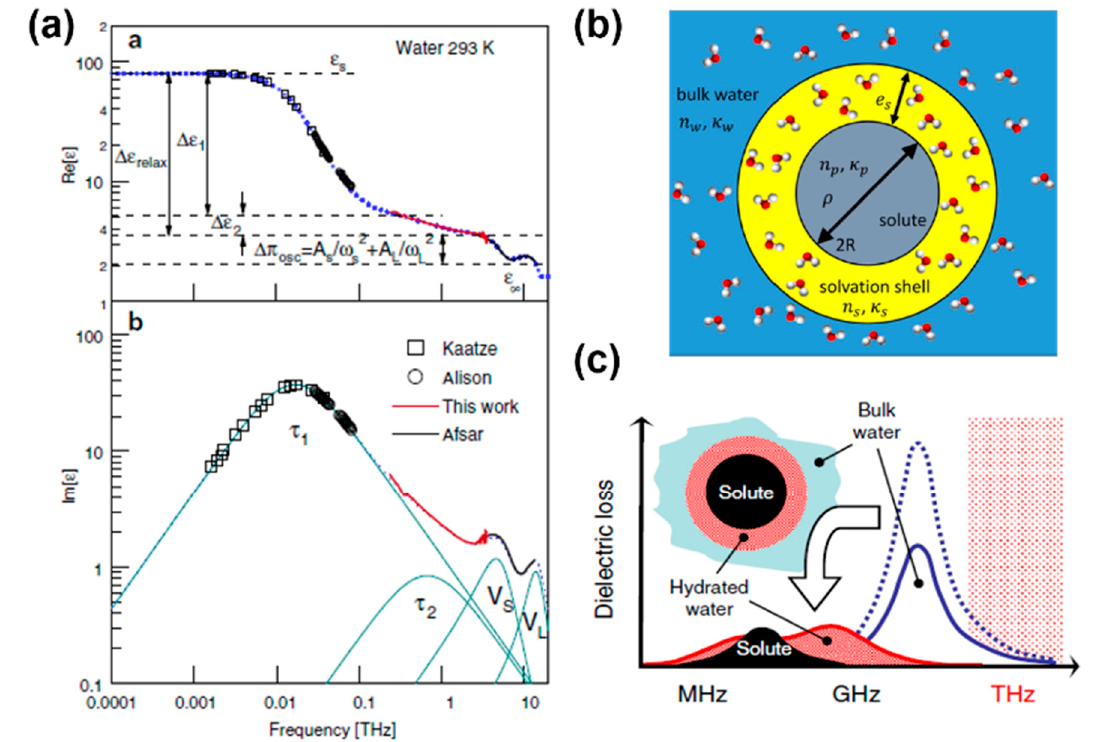
Figure 5. Explanation of dielectric response in the THz region for hydrogen bonds and hydration in aqueous solution. ( a ) The real part (up) and imaginary part (down) of the complex dielectric permittivity of the pure water. Reproduced with permission from [54], Copyright © 2008, Elsevier. ( b ) Model of water molecules and solutes in aqueous, the water molecules are segmented into two stations, bulk water and solvation shell (hydrated water). Reproduced with permission from [56], Copyright © 2017, American Chemical Society. ( c ) Dielectric loss spectra of solute, hydrated water, and bulk water. Reproduced with permission from [57], Copyright © 2008, Elsevier .